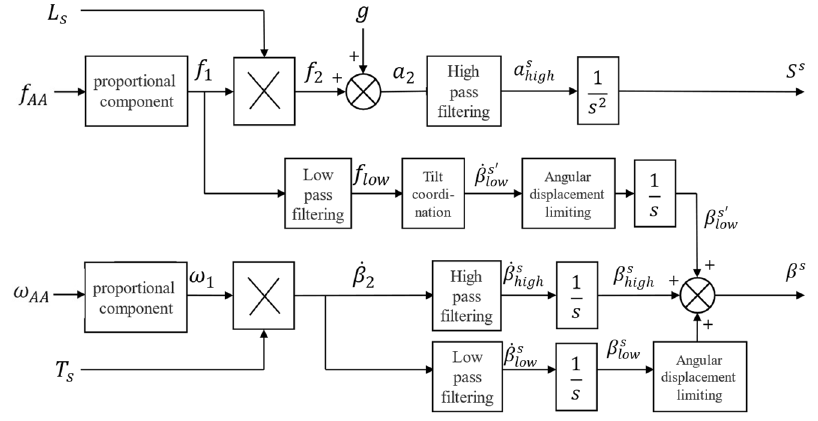
Figure 6. Flow chart of the somatosensory feedback algorithm.